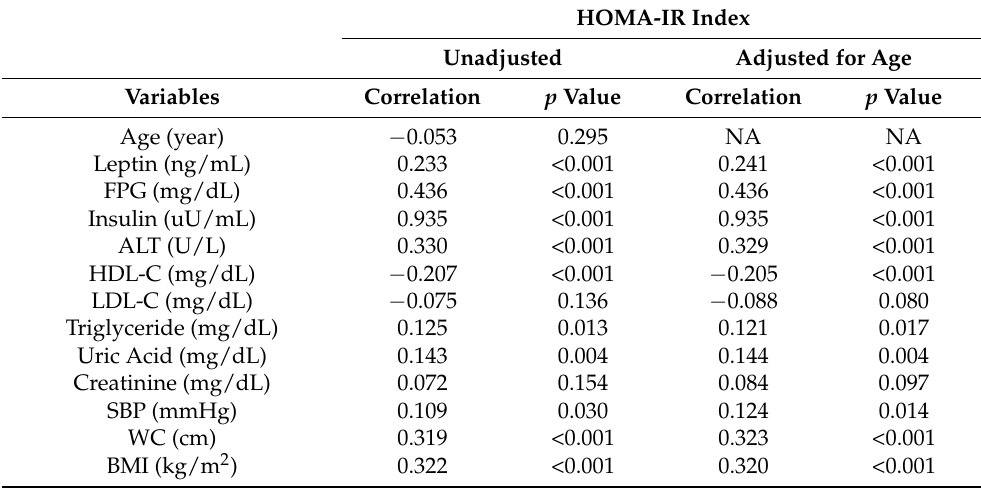
Table 2. Pearson’s correlation coefficients between the HOMA-IR index and cardiometabolic factors. HOMA-IR